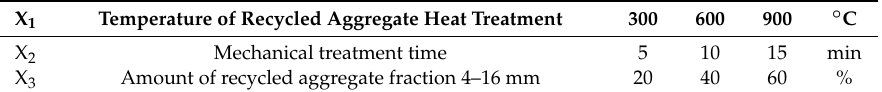
Table 4. Variables in the experiment